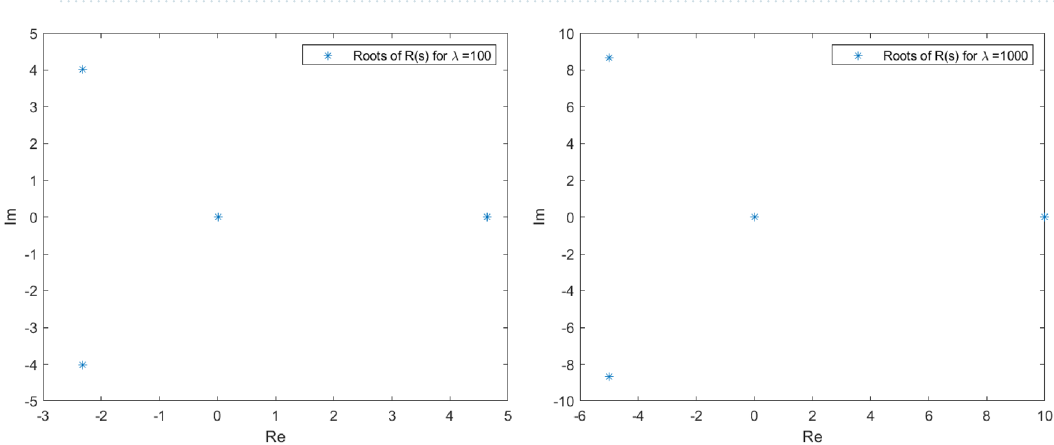
Figure 1. Complex domain (real part—horizontal axis, imaginary part—vertical axis) for (cid:31) = 1 (left) and (cid:31) = 10 (right). Evolution of R ( s ) roots in the complex domain considering � 1 < ǫ → 0 and | y | µ at least one root has Re ( s ) > 0 .